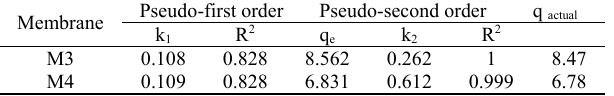
Table 4. The fitting parameters of adsorption kinetic model